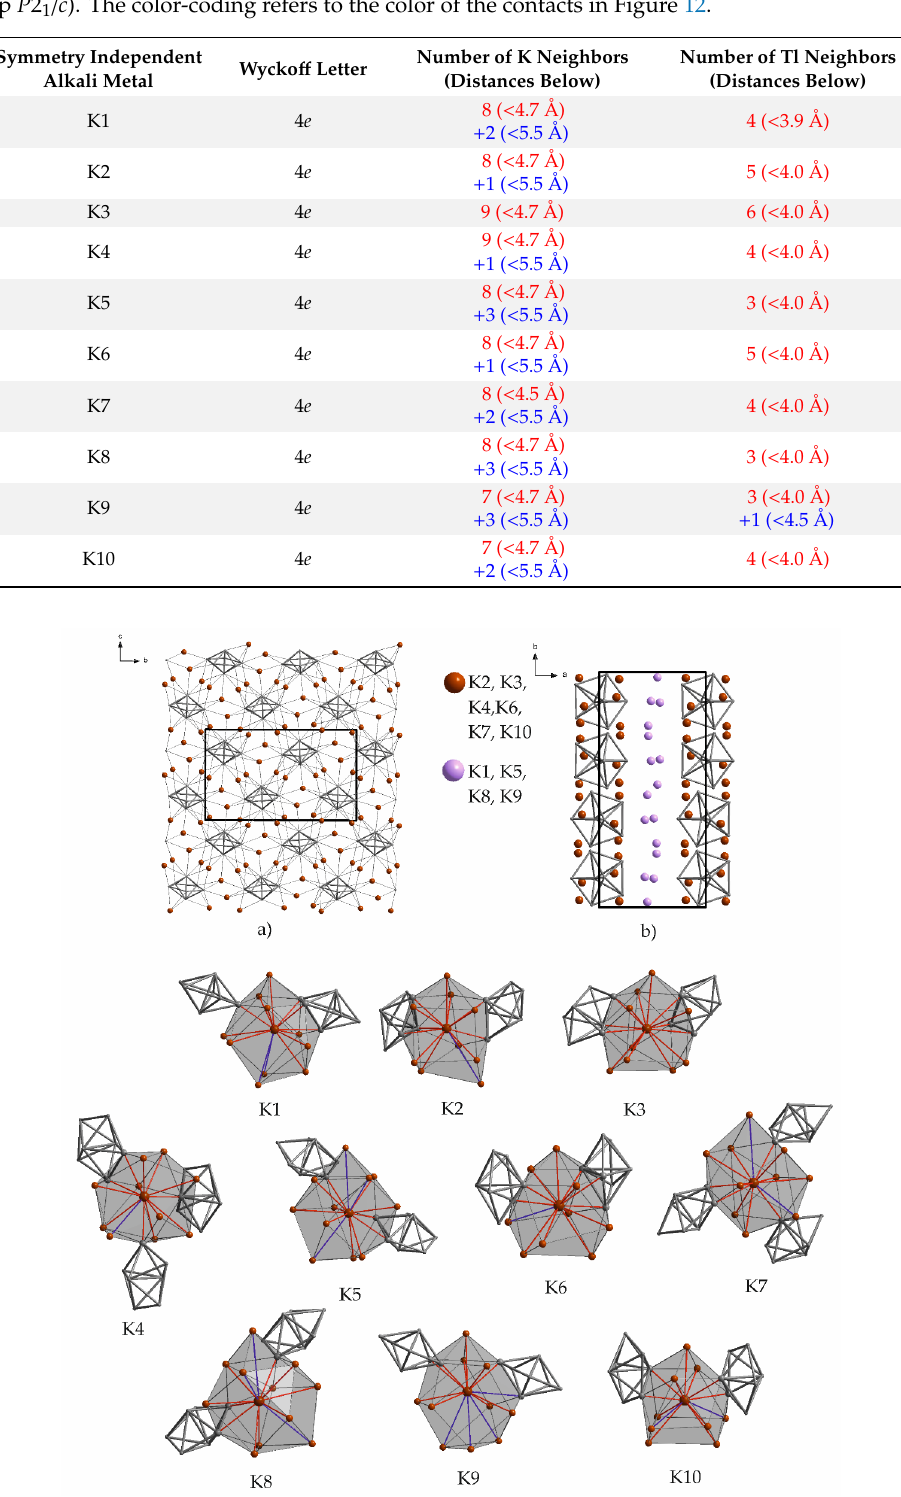
Figure 12. ( a ) Layers of interconnected, pseudo hexagonal packed Tl 7 7 − anions (viewing direction along a); ( b ) unit cell of K 10 Tl 7 , viewing direction along c. Below: Atomic environments of the symmetry inequivalent alkali metals in crystal structures of binary K 10 Tl 7 . The corresponding range of distances to the adjacent atoms as well as the Wycko ff letters are given in Table 14. Shorter contacts are colored red, longer distances are given in blue. The color coding is also used in the corresponding